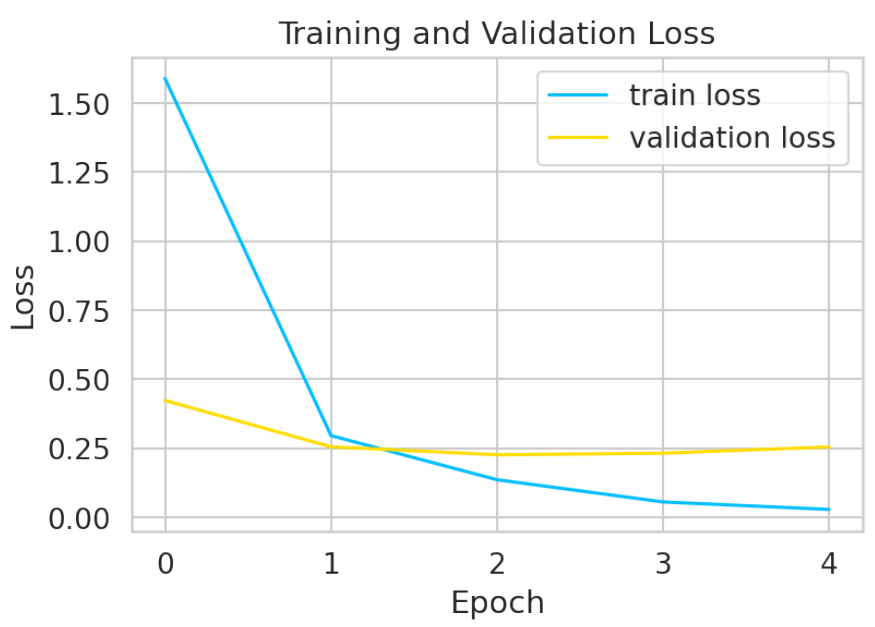
Figure 14. Training and validation loss for